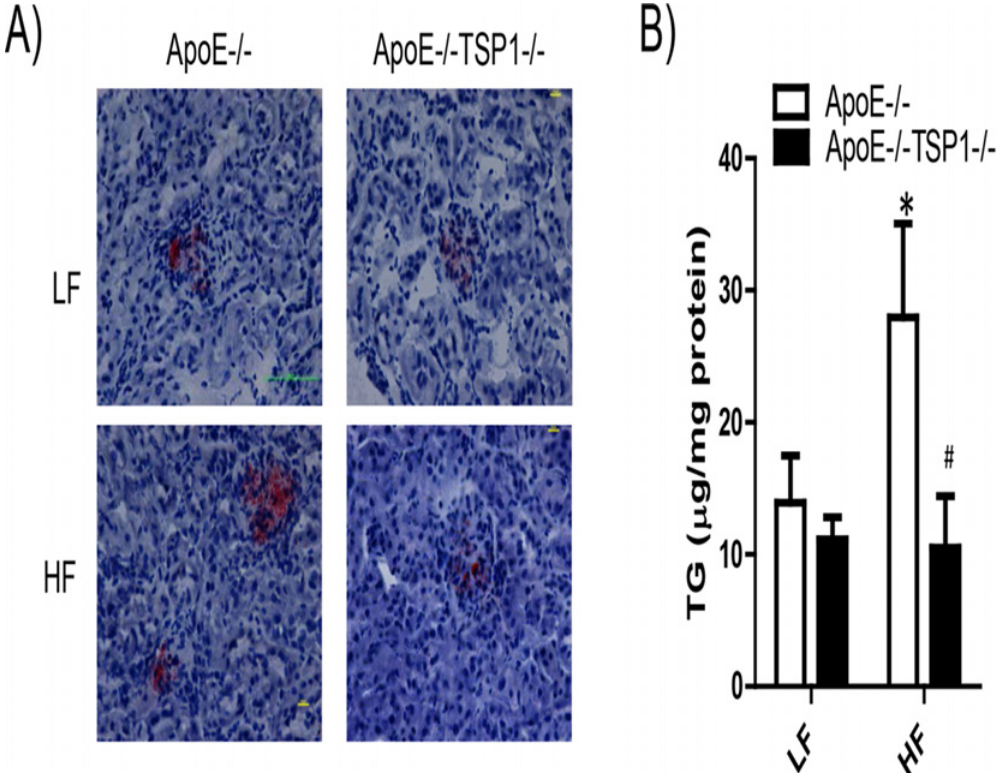
Fig 6. TSP1 deficiency reduced lipid accumulation in the kidney in ApoE-/- mice under HF feeding conditions. (A). Representative photograph of Oil red O staining of frozen kidney sections from 4 groups of mice. Lipid droplets were shown as red spots. (B). Triglyceride contents were measured in lipid extracts from kidney samples. Data are represented as mean ± SE (n = 6 mice/group). * P < 0.05 vs. LF ApoE-/-. # P < 0.01 vs. HF ApoE-/-.